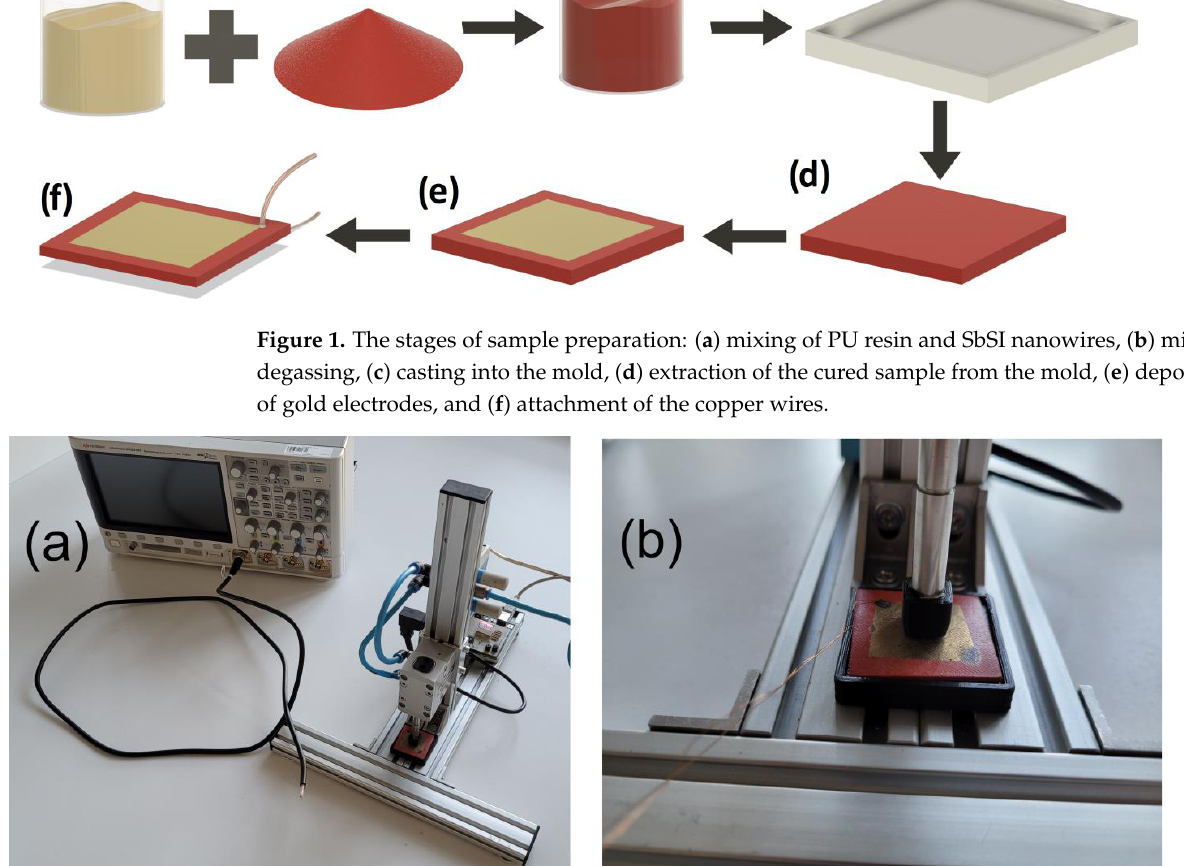
Figure 2. The photographs of ( a ) entire measurement setup and ( b ) sample clamped in the holder.